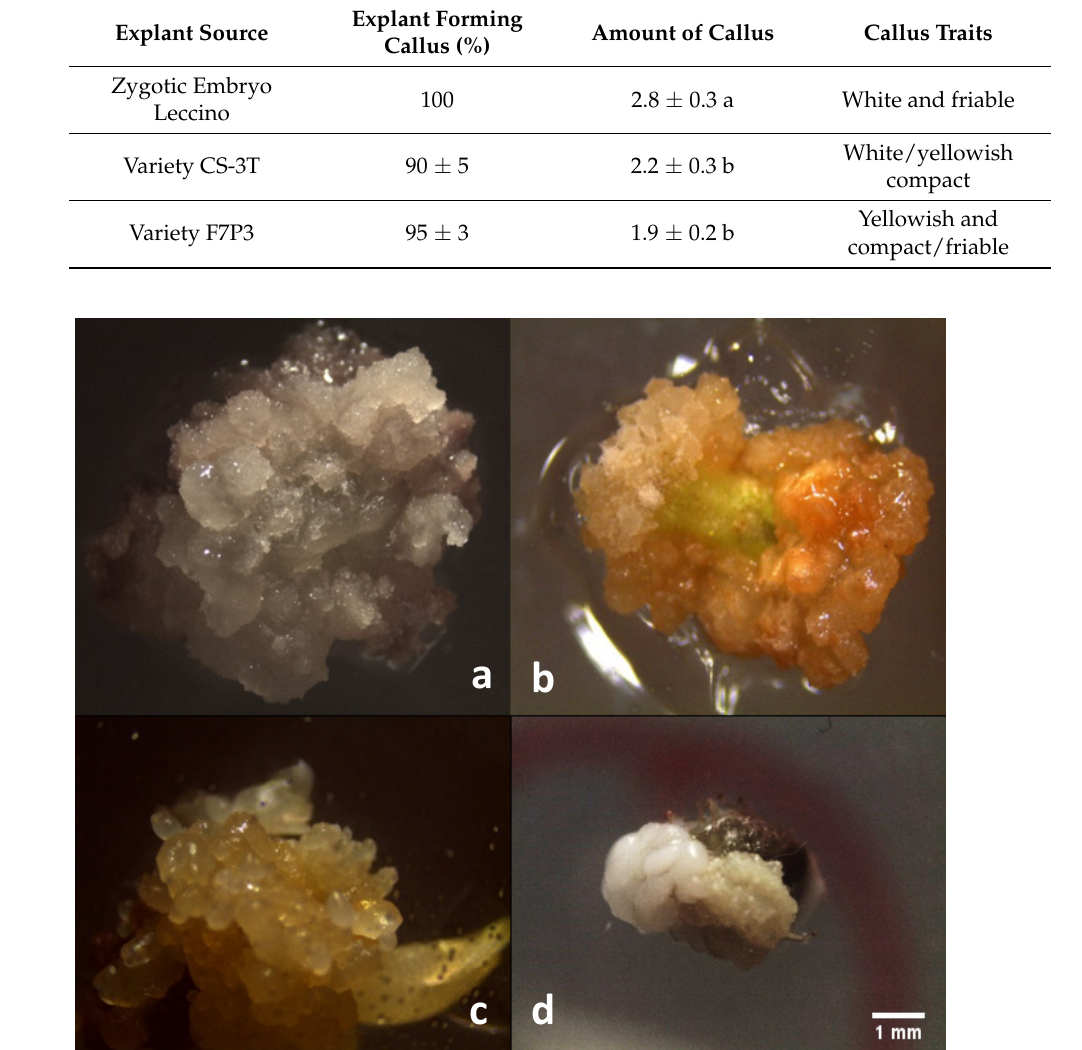
Table 2. The callus formation of the different explant sources of the immature embryos of cv. Leccino, and the leaflets of growing shoots from the varieties CS-3T and F7P3, after 4 weeks on the induction medium. Data are reported as the mean ± standard deviation. The mean denoted by different letters are significantly different (Duncan’s test, p < 0.05). The amount of callus formation has been estimated by an arbitrary scale (0 no callus, 1: < 40%, 2: 40–80%, and 3: 80–100%) on visual criteria, as recommended by [15].